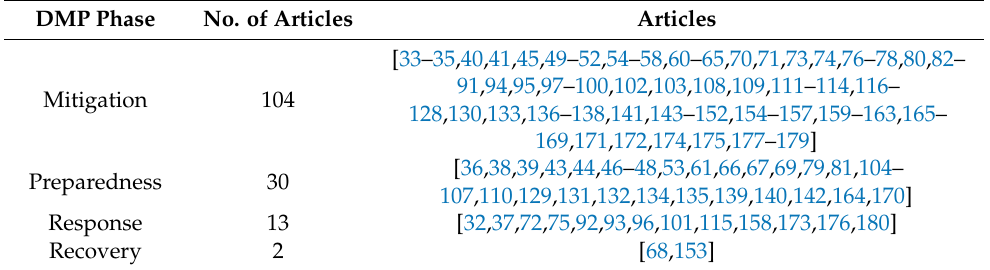
Table 7. Categorization of articles based on